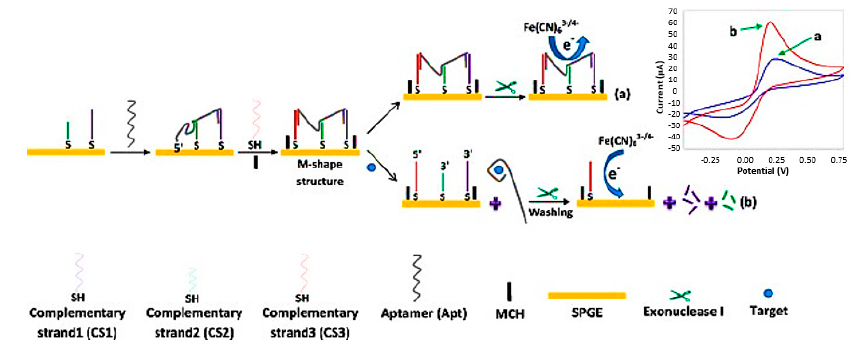
Figure 6. Assay formats of an electrochemical aptasensor for tetracycline detection. When tetracycline is absent, the M-shape structure is formed due to aptamer binding to CSs, resulting in the inhibition of redox probe access to the electrode surface and a reduced electrochemical signal ( a ). When tetracycline is present, it is captured by the aptamer and the M-shape structure is not formed. As a result of degradation of CS1 and CS2 by Exo 1, the redox probe has access to the electrode surface and the electrochemical signal increases ( b ). (Adapted from Taghdisi et al. [67] with permission).